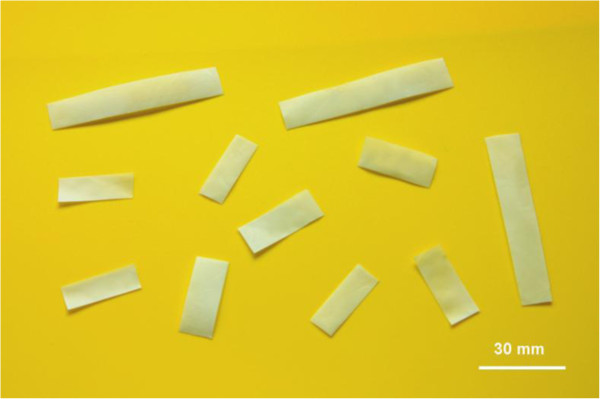
Image of biodegradable PCL film. The biofilm had a supple texture and smooth surface, and was surgically manageable and easily incorporated at the repair site.